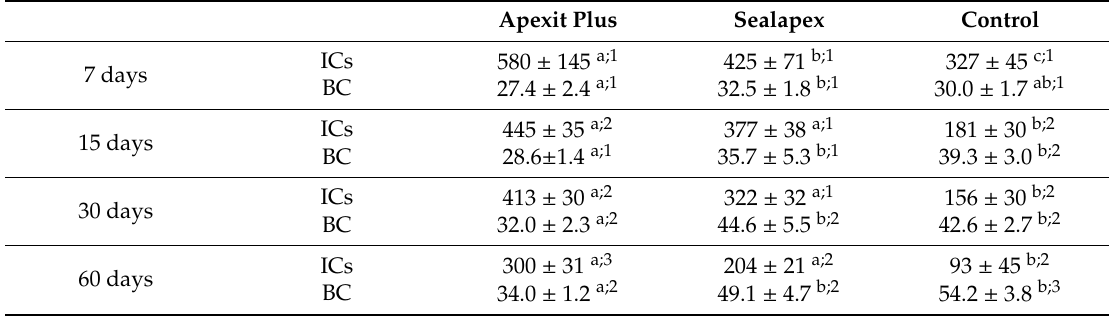
Table 3. Number of inflammatory cells (ICs) per mm 2 and content (in percentage) of birefringent collagen (BC) in the capsules of the Apexit Plus, Sealapex, and control groups. Apexit Plus